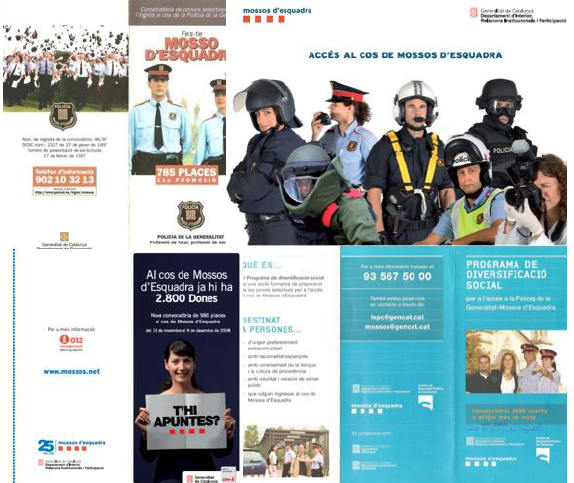
Figure 3. Diversity in publicity for the Mossos